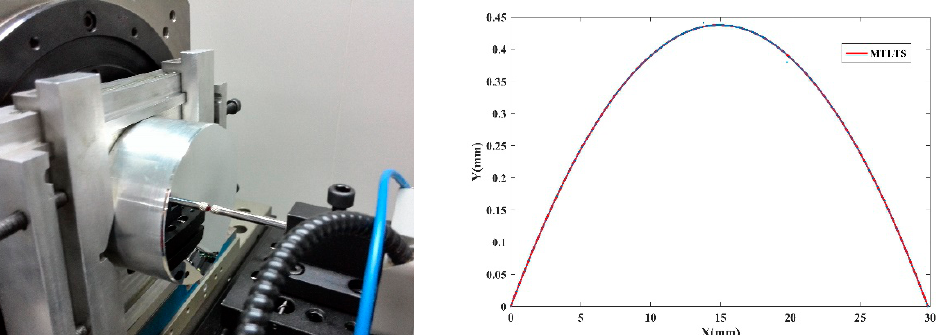
Figure 12. The measurement of the generatrix of spherical surface.